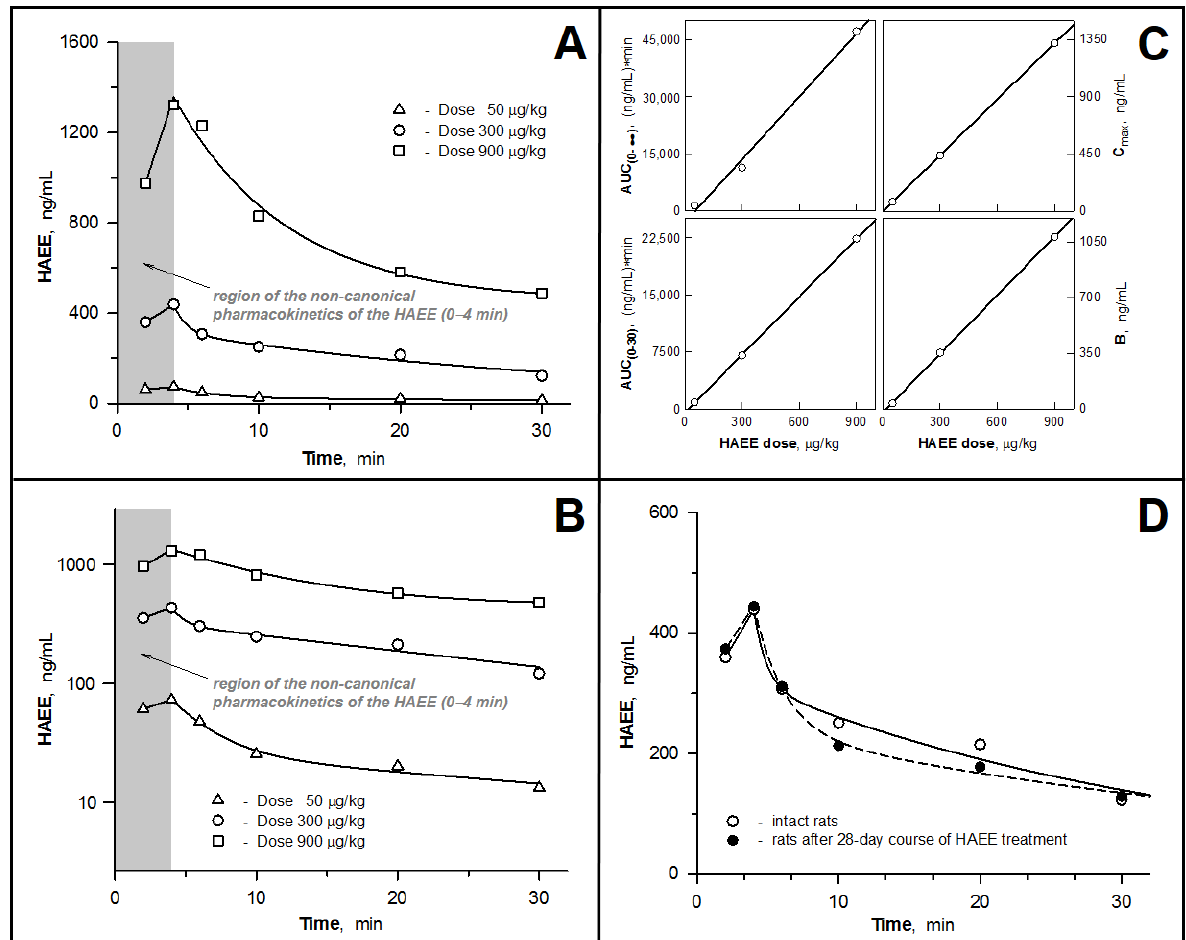
Figure 2. Pharmacokinetics of HAEE in rat blood after a single intravenous bolus injection at doses of 50, 300 and 900 µ g/kg. ( A , B ). Effect of HAEE dose on HAEE pharmacokinetics. Data are presented in straight ( A ) and semi-logarithmic ( B ) coordinates. ( C ). Verification of the linearity of HAEE pharmacokinetics versus the peptide dose. ( D ). Analysis of the effect of long-term course administration of HAEE on the pharmacokinetics of the